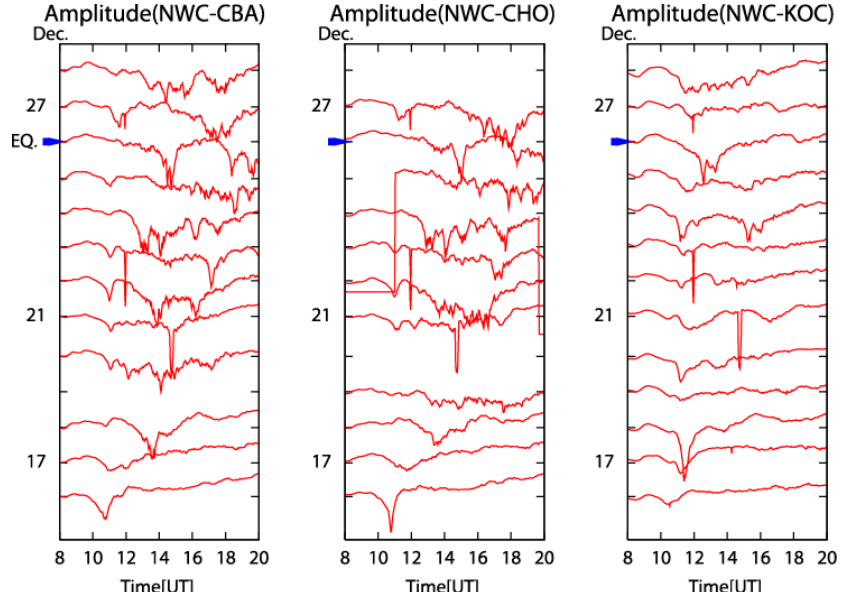
Figure 6. Sequential plot of nighttime amplitude data of the NWC signal as observed at three Japanese observing stations (from left to right: CBA, CHO and KOC). Date goes from the bottom to the top, and the earthquake date is given by EQ. Time is given in UT, so that the Japanese local time (LT) is given by UT + 9